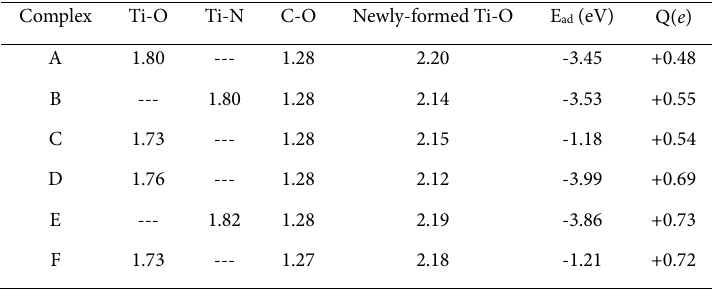
Table 1. Bond lengths (in Ǻ), adsorption energies (in eV) and Mulliken charge results for the interaction of aspirin with TiO 2 anatase nanoparticles.